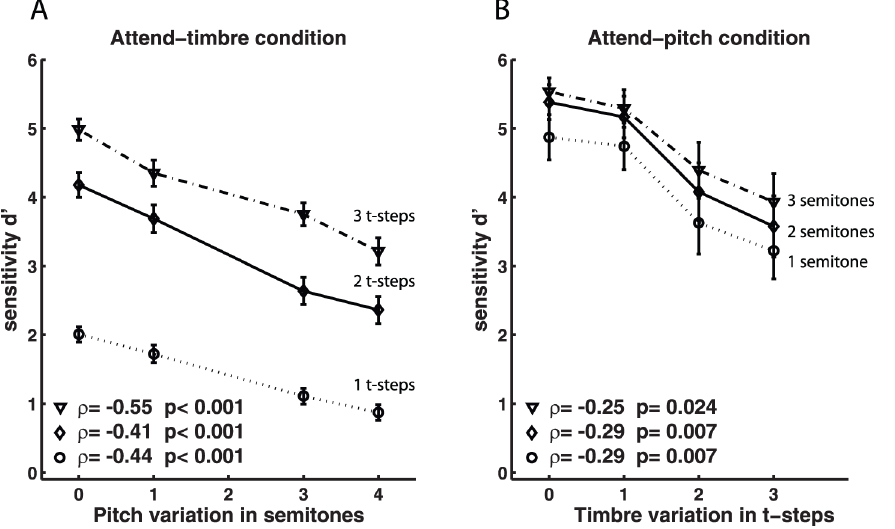
Figure 2. Average sensitivity as a function of pitch and timbre variations. Values represent average d’ score ( 6 SE) across subjects, for each intra-pair distance along the attended dimension (1step circle, 2 steps diamond or 3 steps triangle) and un-attended dimension (on the x-axis). (A) attend-timbre condition, n=57 for each data point; (B) attend-pitch condition, n=21 for each data point. r indicates the Spearman rank correlations coefficient between the d’ scores and the variations along the un-attended dimension, p indicates the p-values for the significance